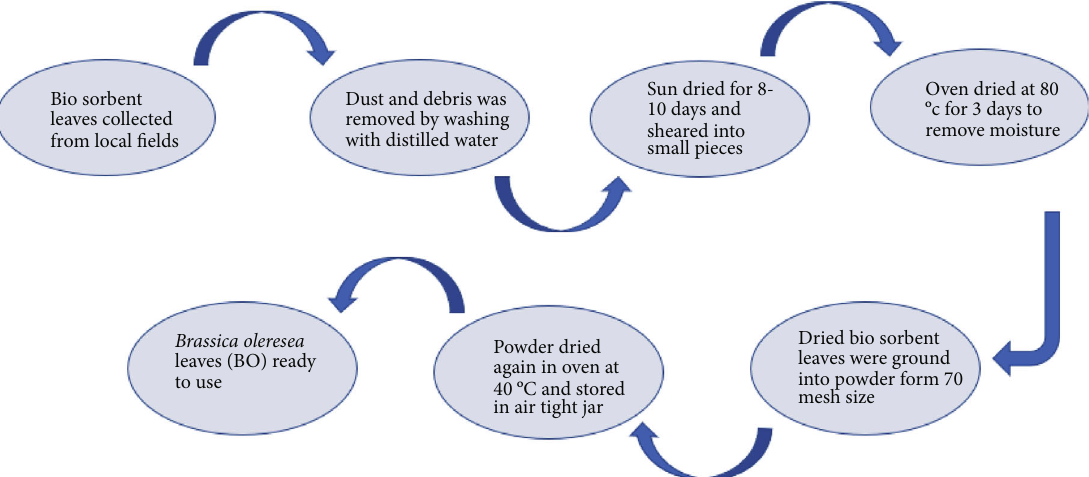
Figure 2: Schematic representation of the steps involving preparation of adsorbent. The biosorbent BO was characterized using various useful techniques, i.e., Boehm titration (to determine acidic and basic moieties) pH, and other physioanalytical data Table 1 [27]. FTIR and SEM were also carried to get further understanding of the sorbent behavior.